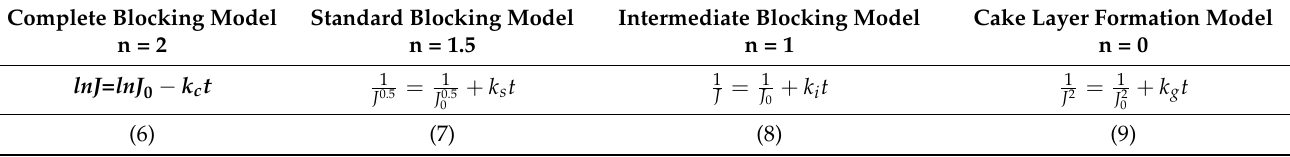
Table 1. Equations for describing fouling Table 1 . Equations for describing fouling mechanism.